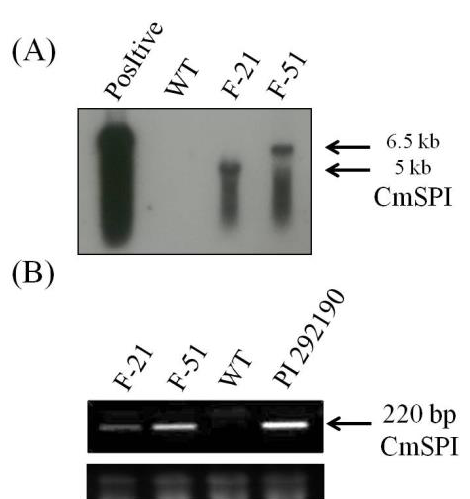
Figure 7. Southern hybridization and RT-PCR analysis of CmSPI T 2 transgenic N. benthamiana lines. ( A ) Southern hybridization analysis of DNA isolated from wild type N. benthamiana control (WT), CmSPI T 2 transgenic lines, T 2 F-21-2-5 and T 2 F-51-10-8, with α 32 P-labeled CmSPI probe. CmSPI transformation plasmid DNA was used as a postive control; ( B ) Transcript levels of CmSPI in postive control ( C. metuliferus resistance line PI 292190), negative control WT (wild type N. benthamiana plant), and CmSPI T transgenic lines (T F-21-2-5 and T F-51-10-8). Total RNA from PVY inoculated plants at 2 dpi was analyzed by RT-PCR. The ethidum bromide-stained rRNA is shown as a loading control